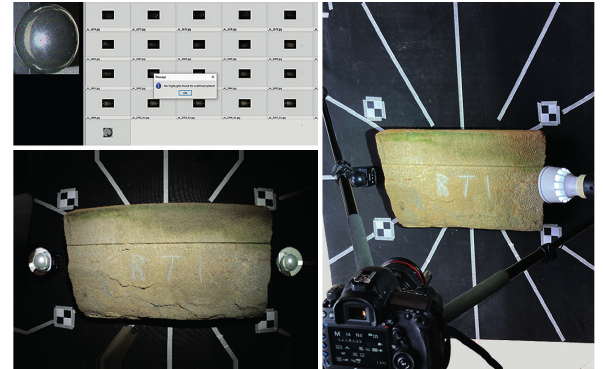
Figure 5. The photographic capture set for laboratory